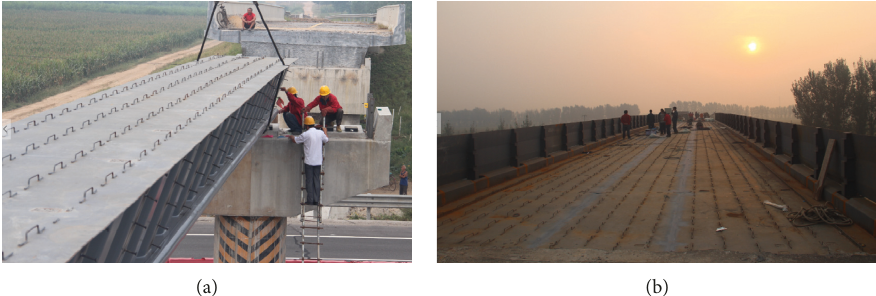
Figure 3: (a) Fabrication of one bridge girder with the proposed deck slab (b) Welding the steel members of the proposed deck slab.